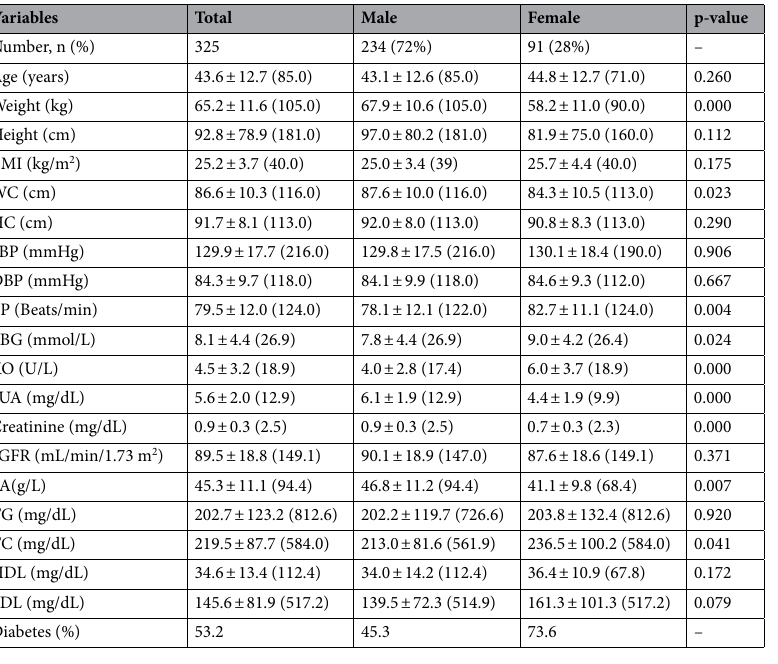
Table 1. Gender-wise baseline characteristics of the study subjects. Values are presented as mean ± SD with maximum values in parentheses. p-values are given for differences between the gender groups and